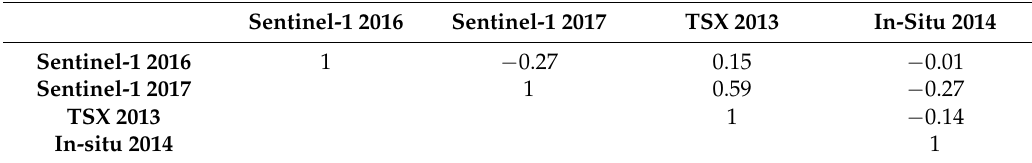
Figure 15. Vertical displacement values extracted from the Sentinel-1 InSAR maps of July-September 2016 and June-October 2017, the TerraSAR-X InSAR map of June-September 2013 and the in-situ measurements of April-August 2014. Where number of measurements per pixel was larger than one, an averaged measurement is considered. Table 2. Correlation coefficients for all combinations of measurements.